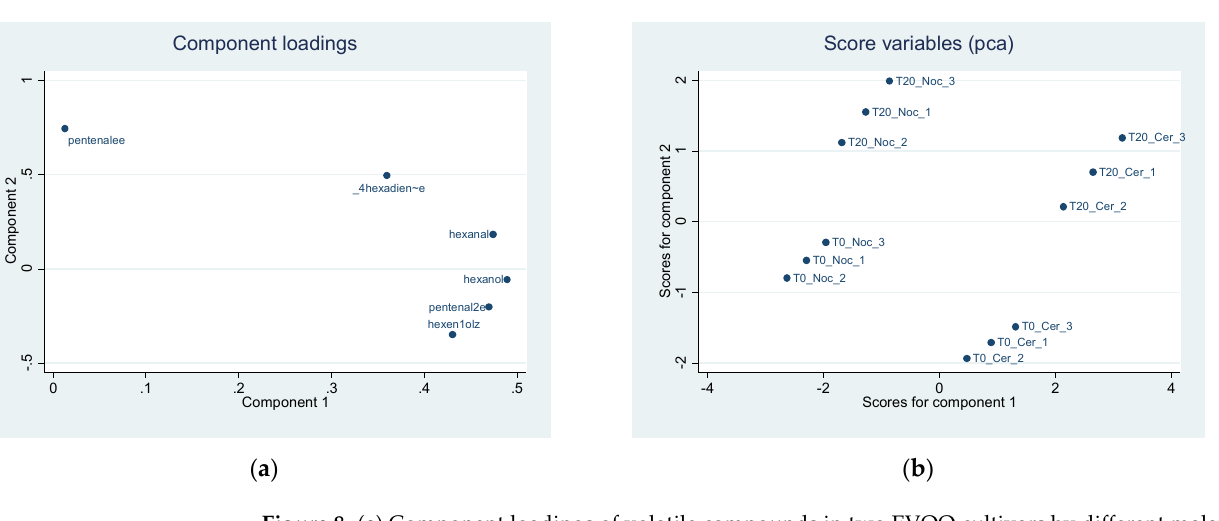
Figure 8. ( a ) Component loadings of volatile compounds in two EVOO cultivars by different malaxation methods (T0 and T20). First two principal component (Component 1 x -axis, Component 2 y -axis) analysis (PCA). ( b ) Predicted scores after PCA obtained as linear combination of the observation data by using eigenvector of component 1 ( x -axis) and eigenvector of component 2 ( y -axis).